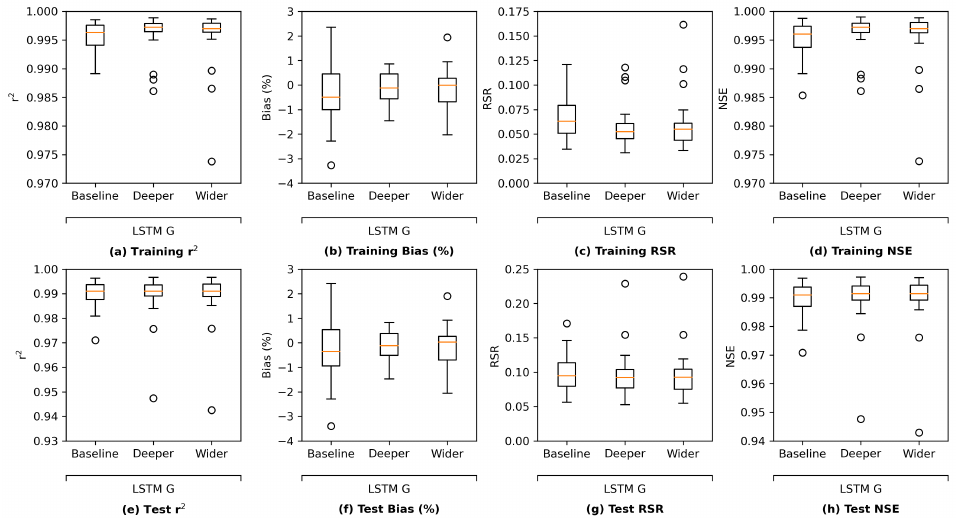
Figure 15. Performance comparison of the baseline LSTM (grouped) versus its deeper and wider versions illustrated in Figure